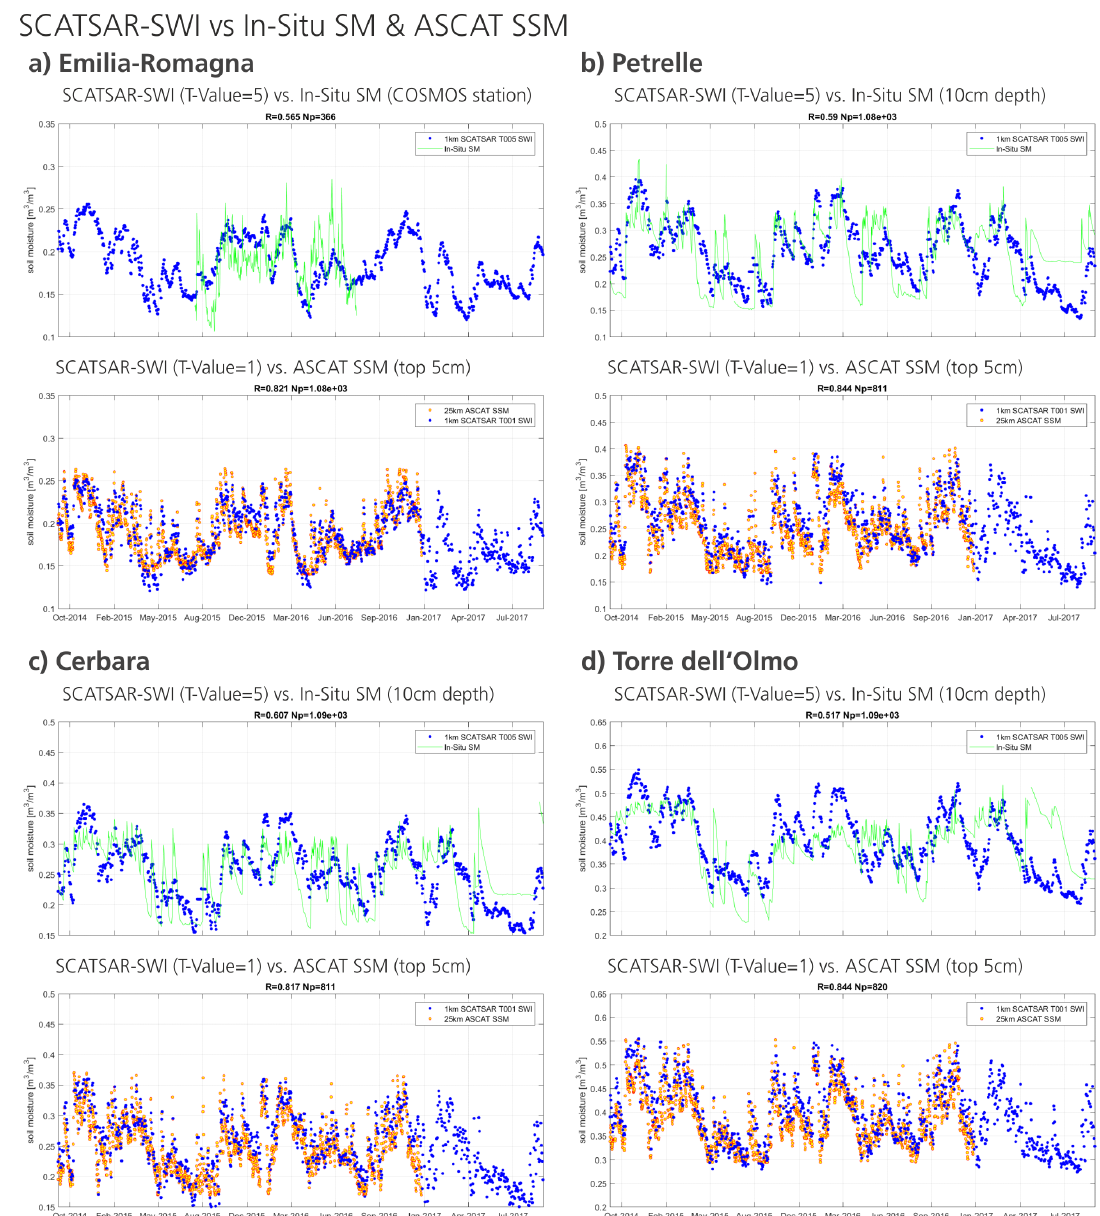
Figure 7. Comparisons of time series of SCATSAR-SWI against references (In situ SM and ASCAT SSM) at selected in situ stations. Values in volumetric units (m 3 m − 3 ). All available data for the period October 2014–August 2017 is displayed. With Pearson Rho (R) and associated sample number of temporally matched data